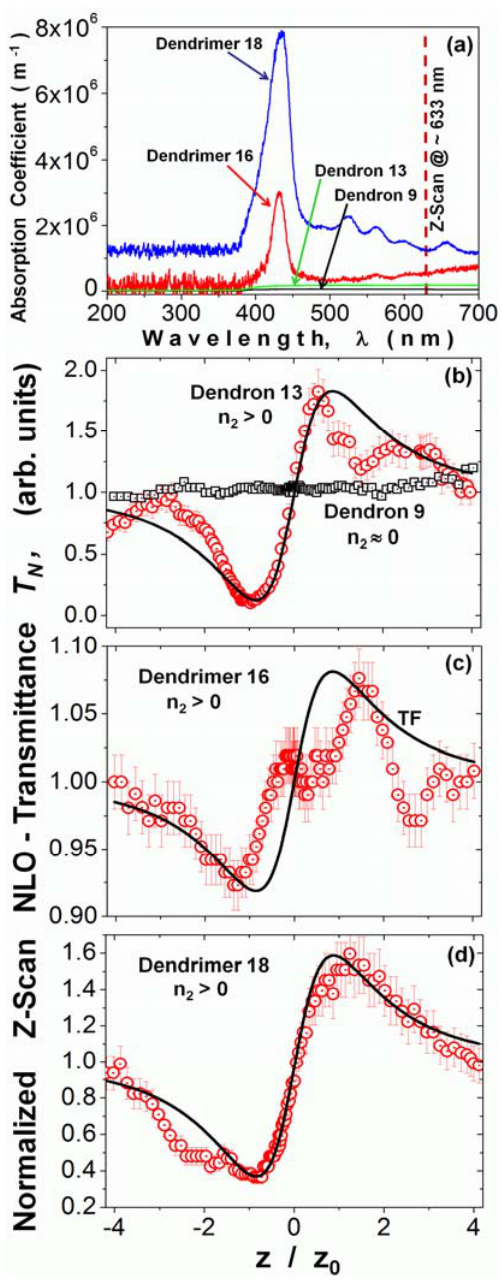
Figure 4. Linear and nonlinear optical measurements obtained for the pristine reference dendrons ( 9 and 13 ) and the dendrimer-based film samples ( 16 and 18 ): ( a ) Linear absorption coefficients of the film samples evaluated within the visible range; ( b ) Closed aperture Z-Scan data obtained at λ = 632.8 nm for the first and second generation Z-Scan dendron-based films; and ( c - d ) closed aperture Z-Scan data obtained for the dendrimer-based films under similar experimental conditions. An estimated experimental error below 5% is also considered for the Z-Scan data (error bars). Theoretical fitting: continuous